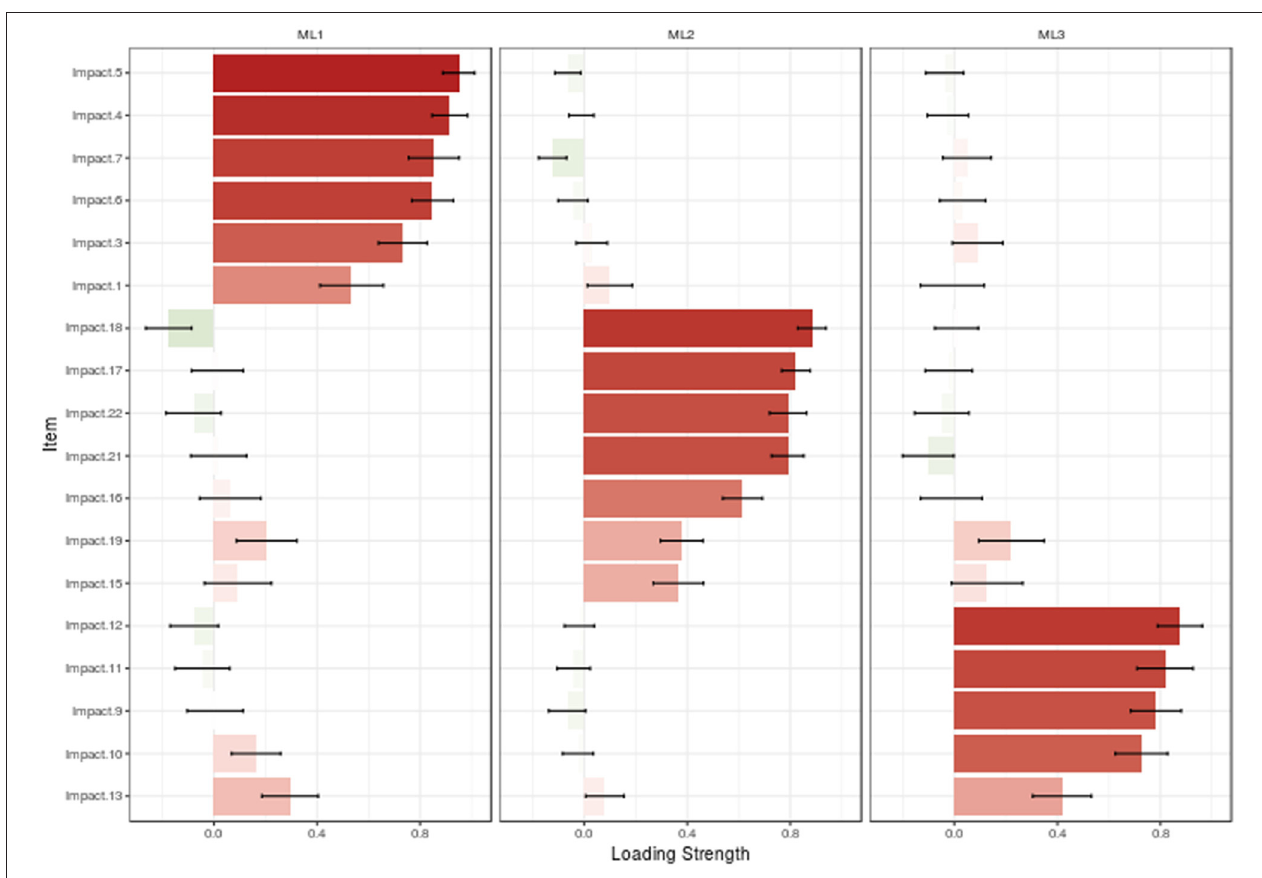
FIGURE 2 | Loading strength of items in